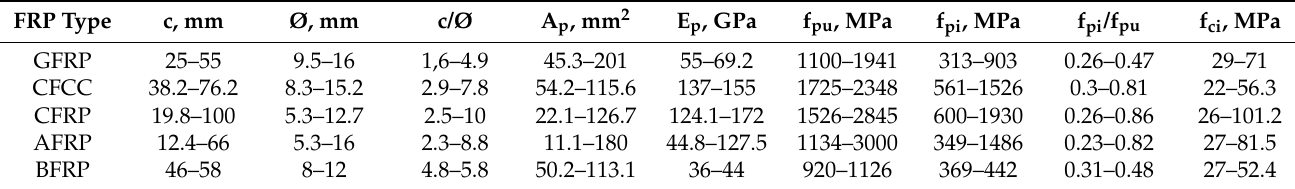
Table 10. Summary of initial parameters of the transfer length